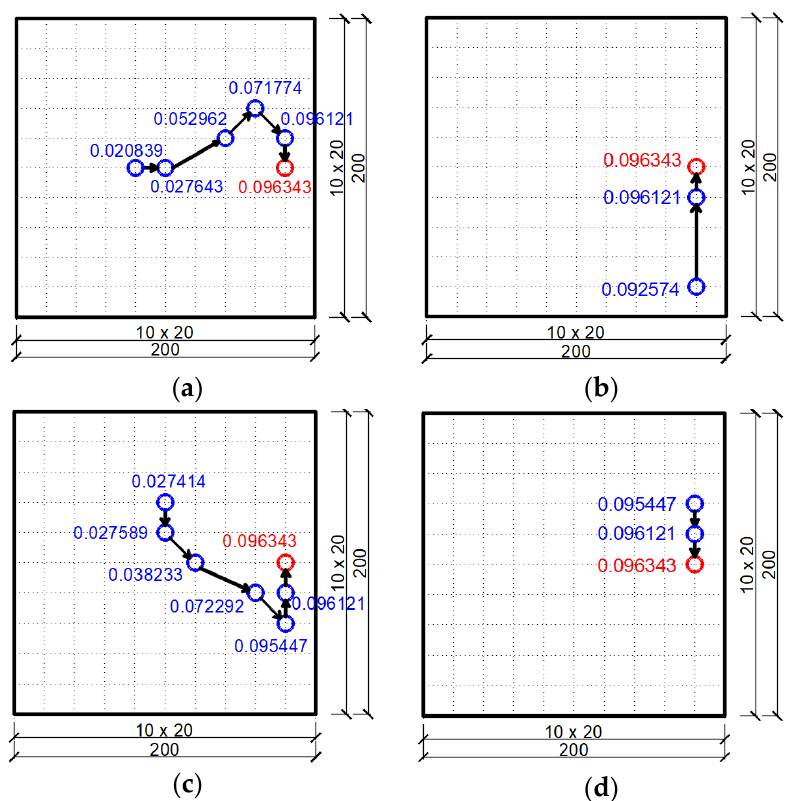
Figure 7. The most favorable positions of the swarm particles achieved in subsequent iterations of the PSO algorithm in individual plate neighborhoods: ( a ) Neighborhood 1; ( b ) Neighborhood 2; ( c ) Neighborhood 3; ( d ) Neighborhood 4.